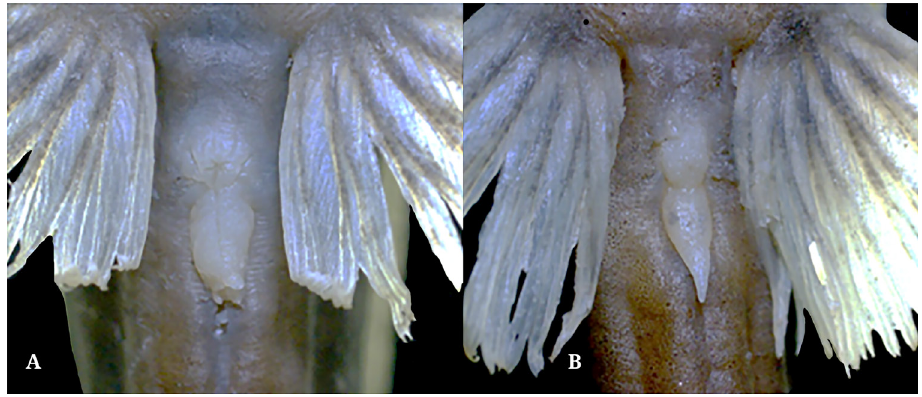
FIGURE 7 | Microglanis berbixae , close up urogenital papillae. A. Female, MECN-DP-3765, 53.5 mm SL. B. Male, MECN-DP-3765, 52.6 mm